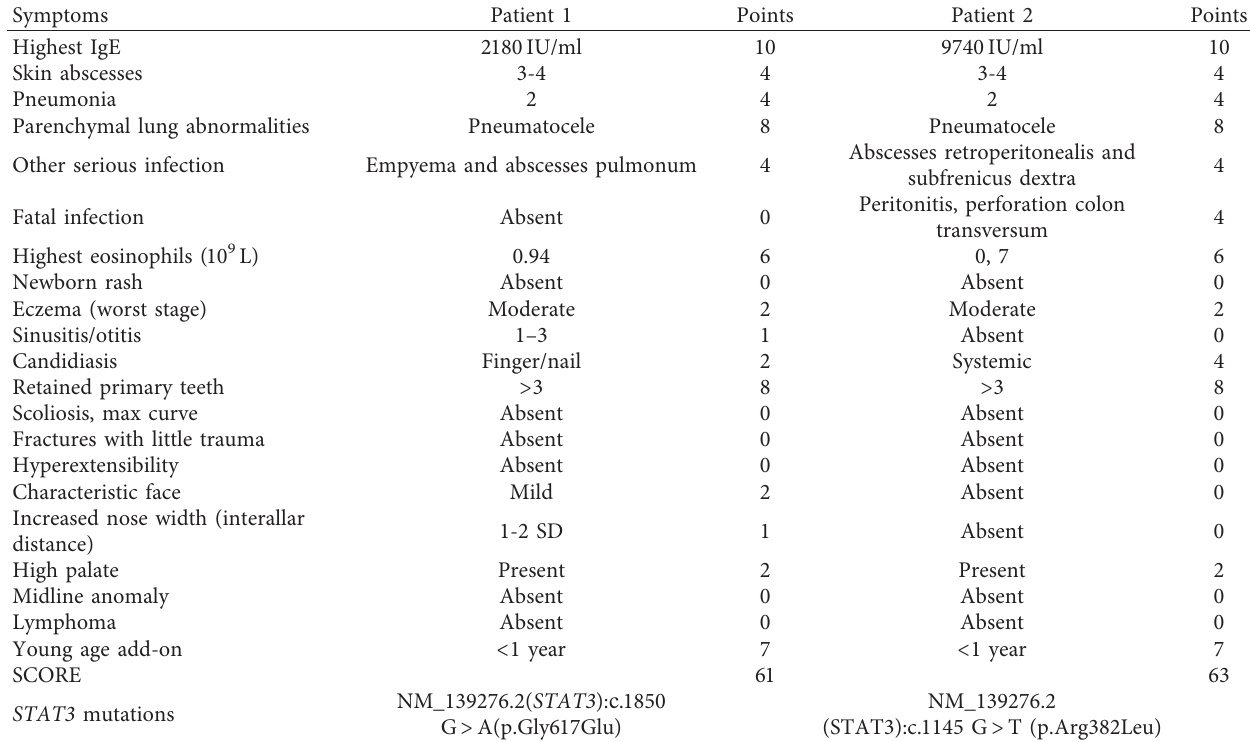
Table 1: Hyper IgE Syndrome Scores and STAT3 mutation data.